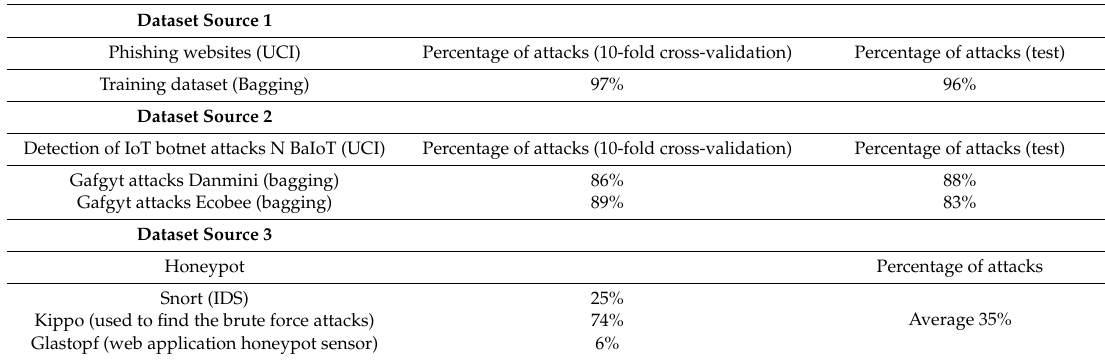
Table 2. Datasets used in this